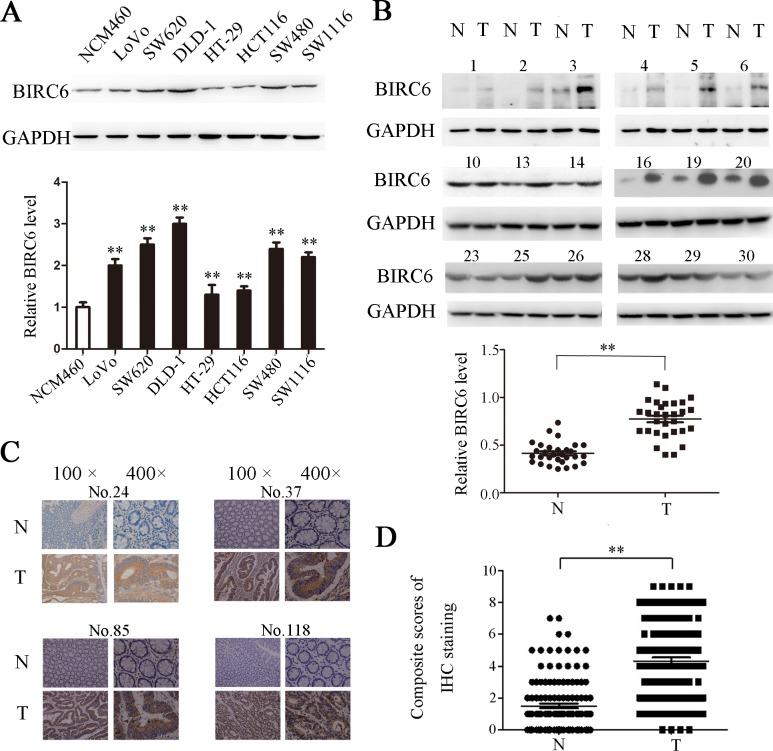
BIRC6 was overexpressed in CRC cell lines and tumor tissues of CRC patients.(A) Expression of BIRC6 in 1 human colon healthy cell line and 7 CRC cell lines. Upper panel: Typical patterns of BIRC6 expression in NCM460 and CRC cell lines. Lower panel: Relative intensity of BIRC6 normalized to GAPDH. Data present Mean ± SEM from three independent experiments. (B) Expression of BIRC6 in 30 paired CRC tissues (T) and adjacent nontumorous tissues (N). Upper panel: Typical patterns of BIRC6 expression in CRC tissues. Lower panel: Relative intensity of BIRC6 normalized to GAPDH. (C) Immunohistochemistry staining of BIRC6 in tumor tissues and self-paired adjacent non-tumorous tissues from four representative CRC patients. (D) Scores of immunohistochemistry staining of BIRC6 in 126 cases. **, P < 0.01.